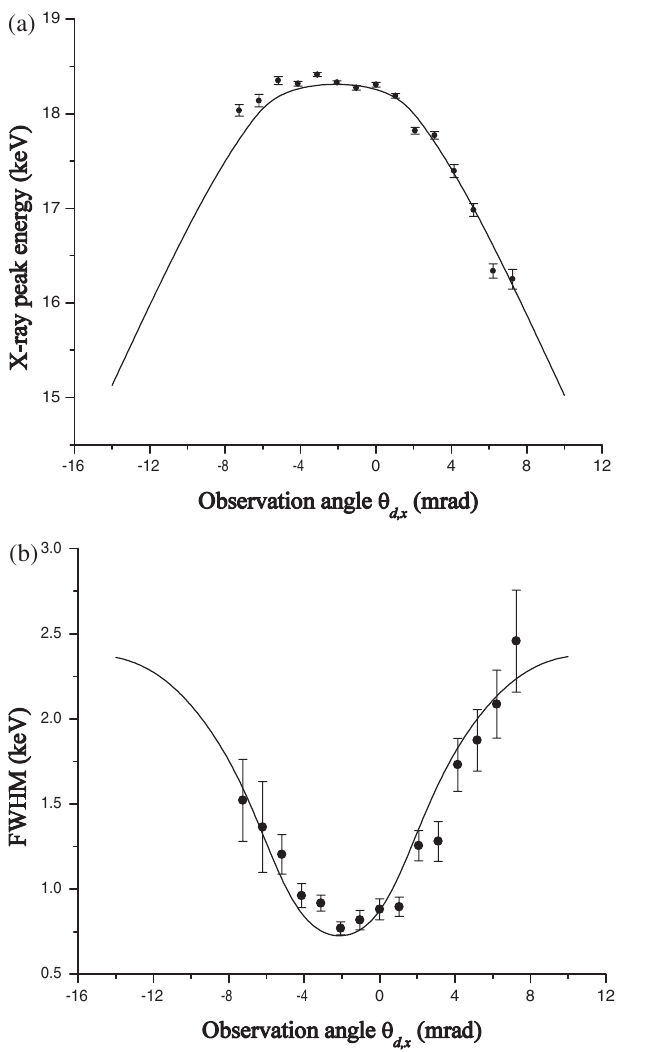
FIG. 12. (a),(b) Variation of LCS x-ray peak energy and FWHM as a function of the detector vertical angle together with curves generated using the parameters from the multiple